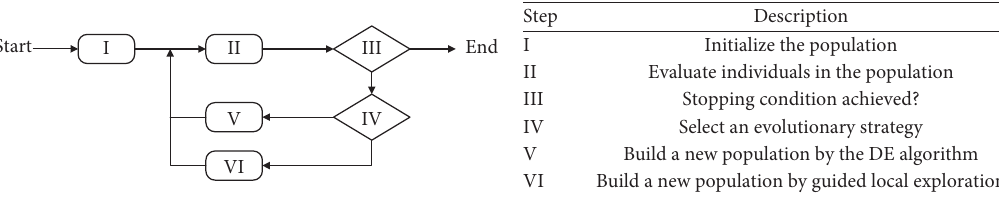
Figure 2: Framework of the